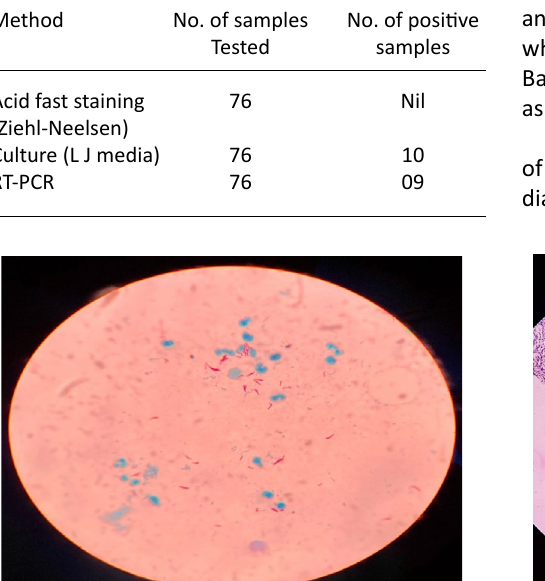
table 6. Different diagnostic modalities used Method No. of samples